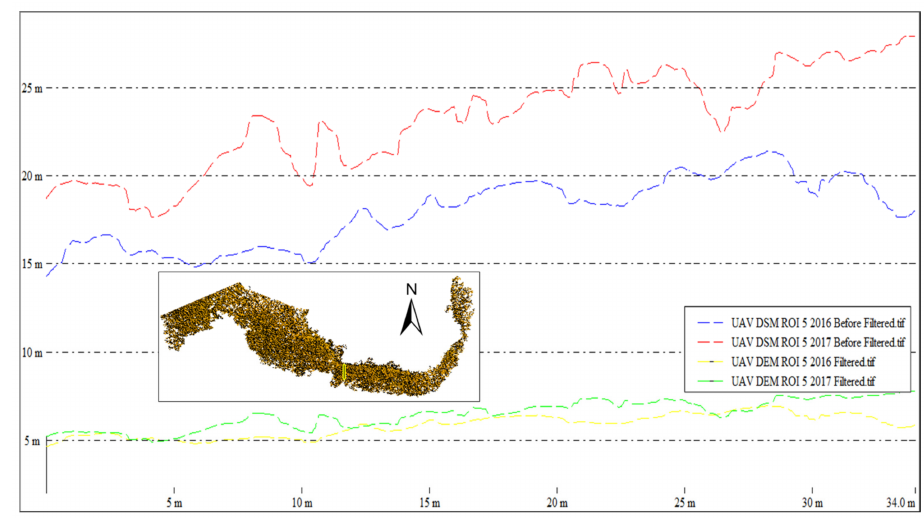
Figure A11. Average height comparison between filtered and unfiltered for ROI 5.